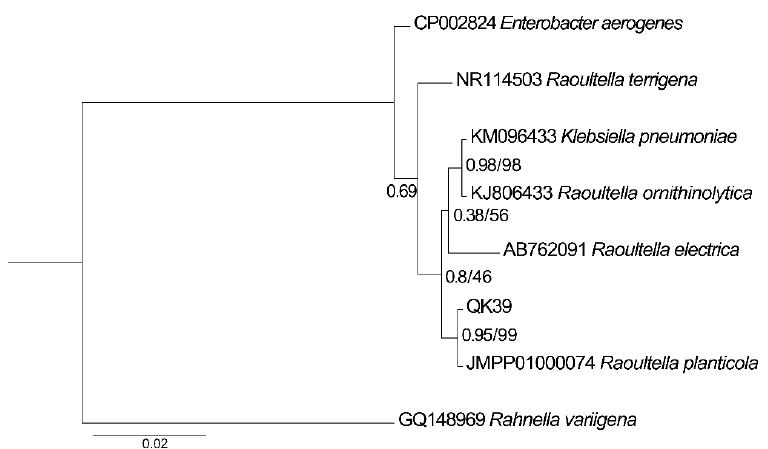
Figure 2. Bayesian phylogenetic tree of 39 # strain based on 16S rDNA. The numbers on the left and right sides of the branch represent the approximate Bayesian test support value and the Neighbor-Joining method bootstrap value.